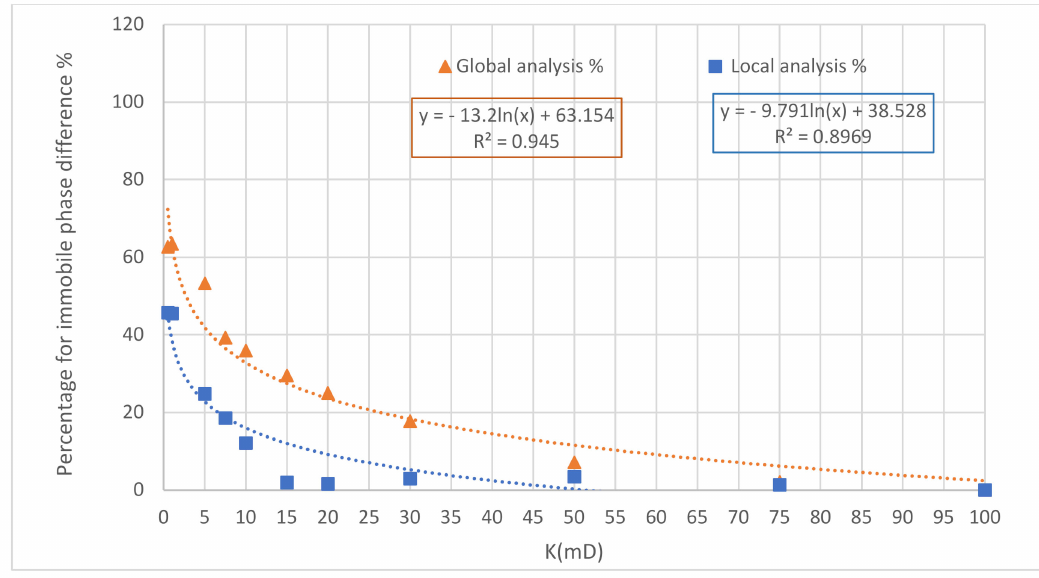
Figure 11. Comparison of percentage of immobile phase condensate versus permeability for global and local analyses.